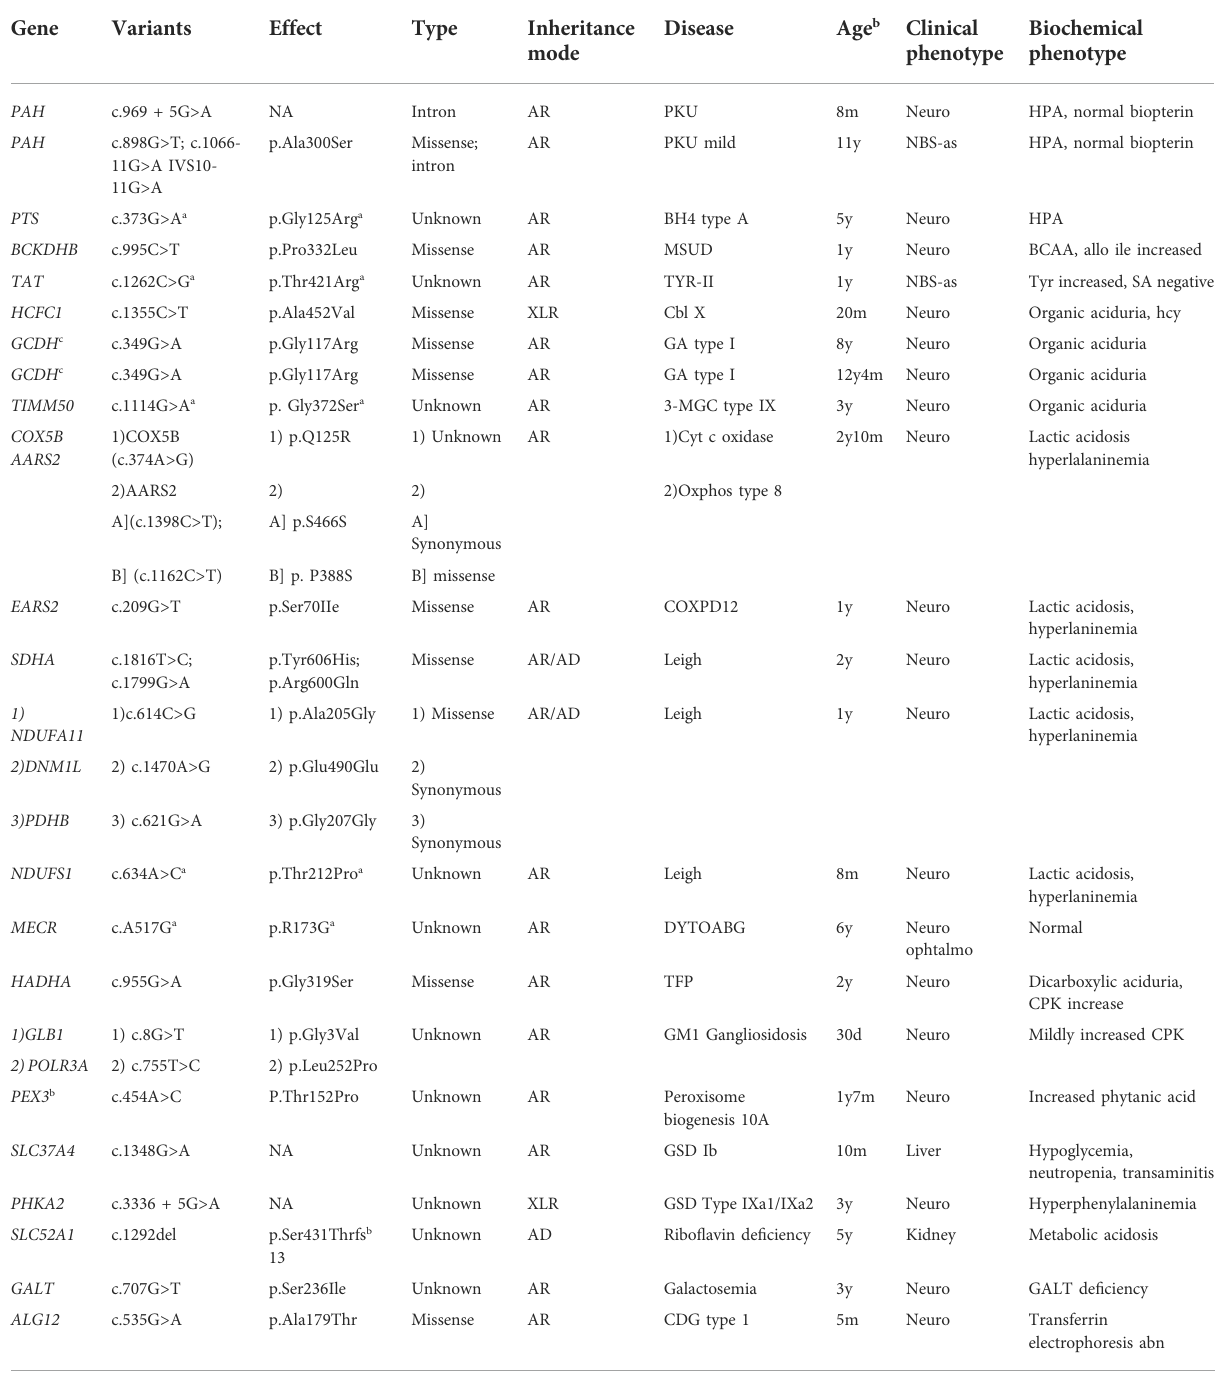
TABLE 1 Variants of unknown signi fi cance identi fi ed in 23 IEM patients with phenotype